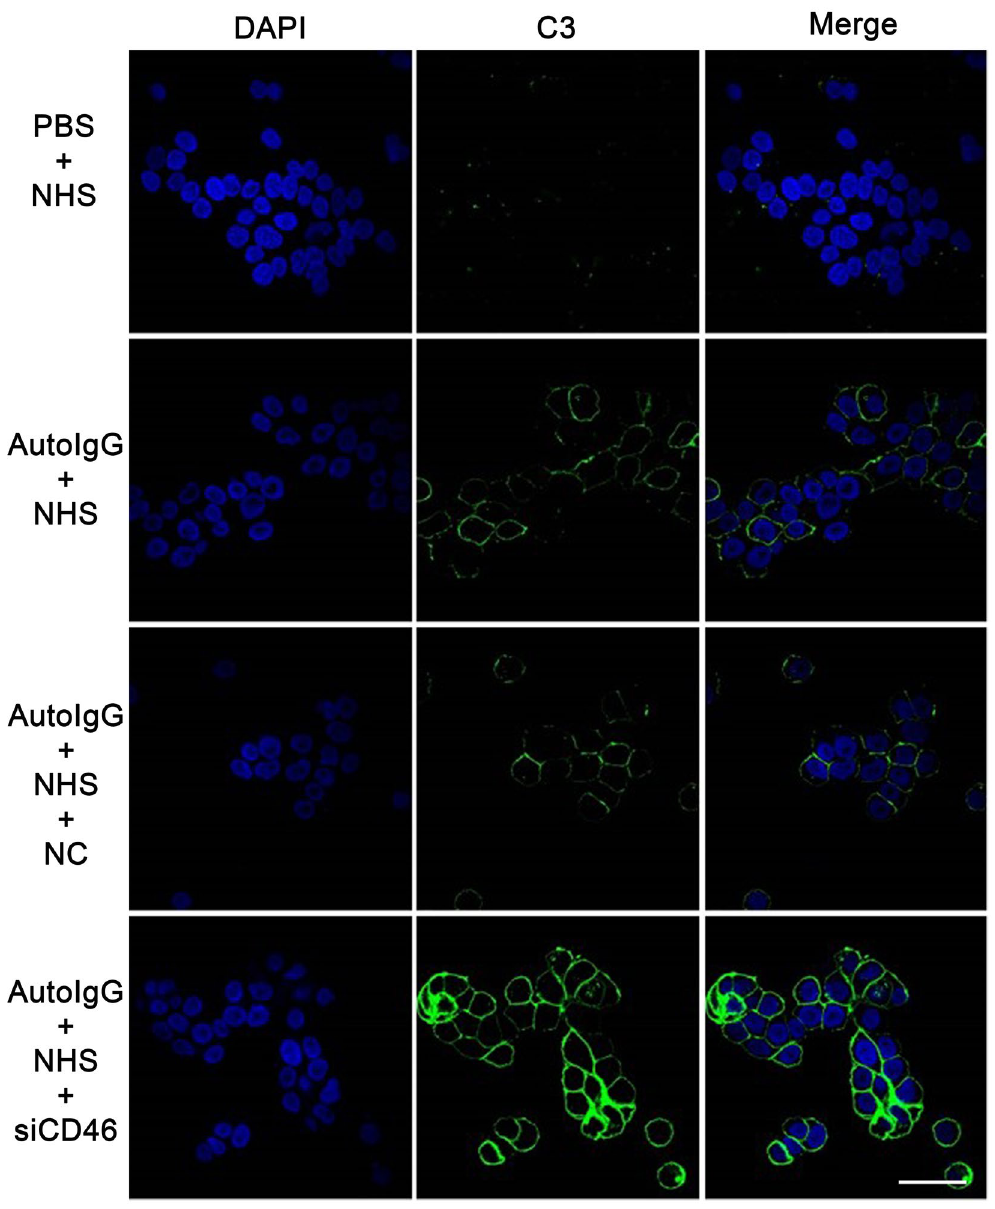
Figure 3. CD46 depletion enhances auto-IgG-mediated C3 deposition in HaCaT cells. HaCaT cells transfected with CD46 siRNA were incubated with purified auto-IgG overnight at 37 °C. Fresh healthy serum containing complement components was added to mimic BP pathogenesis. C3 deposition was detected by IF staining to determine the complement activation level. Scale bar, 25 nm. Auto-IgG, pathogenic IgG from BP patients’ serum; NHS, normal human serum; NC, negative control